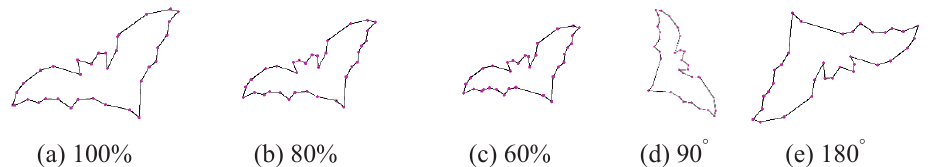
Figure 7. Original image at full scale ( a ), 80% scale ( b ), 60% scale ( c ), 90 ◦ rotations ( d ), 180 ◦ rota- tions ( e ).